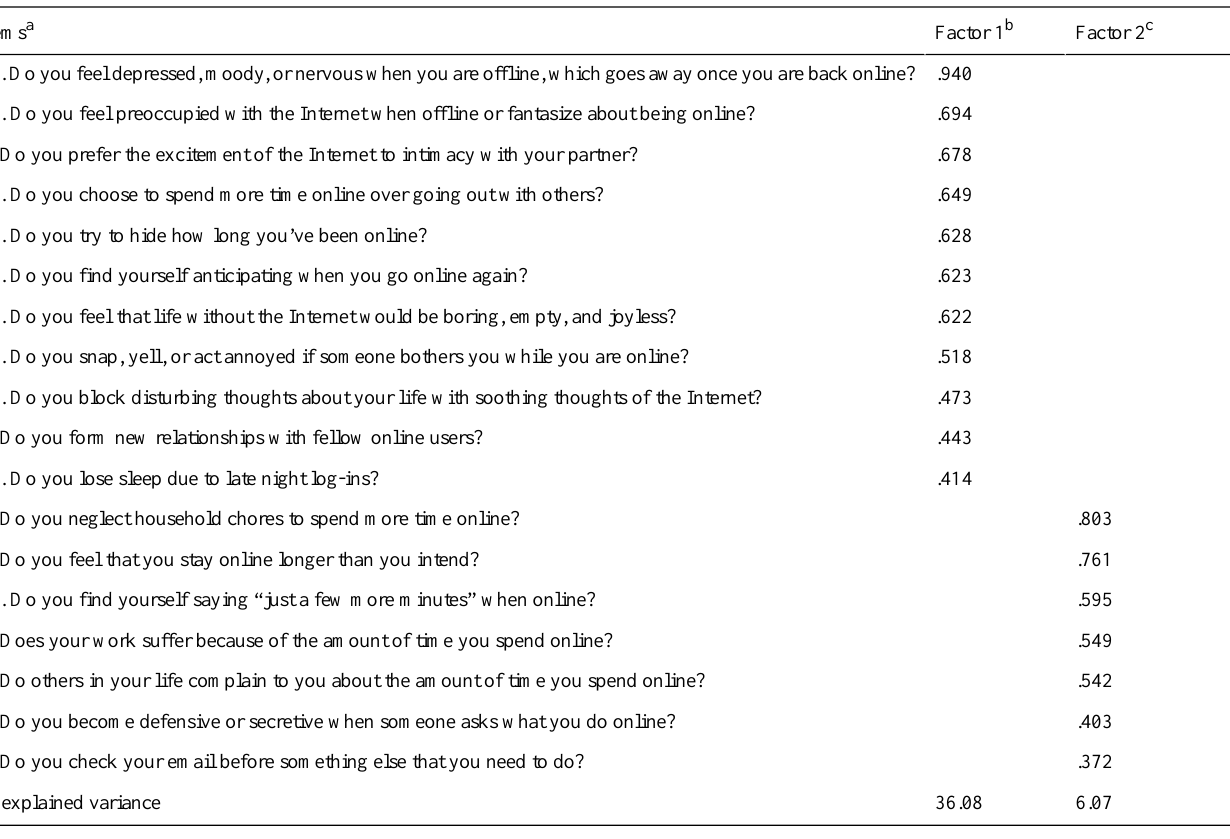
Table 1. Factor loadings of the IAT items for the two-factor